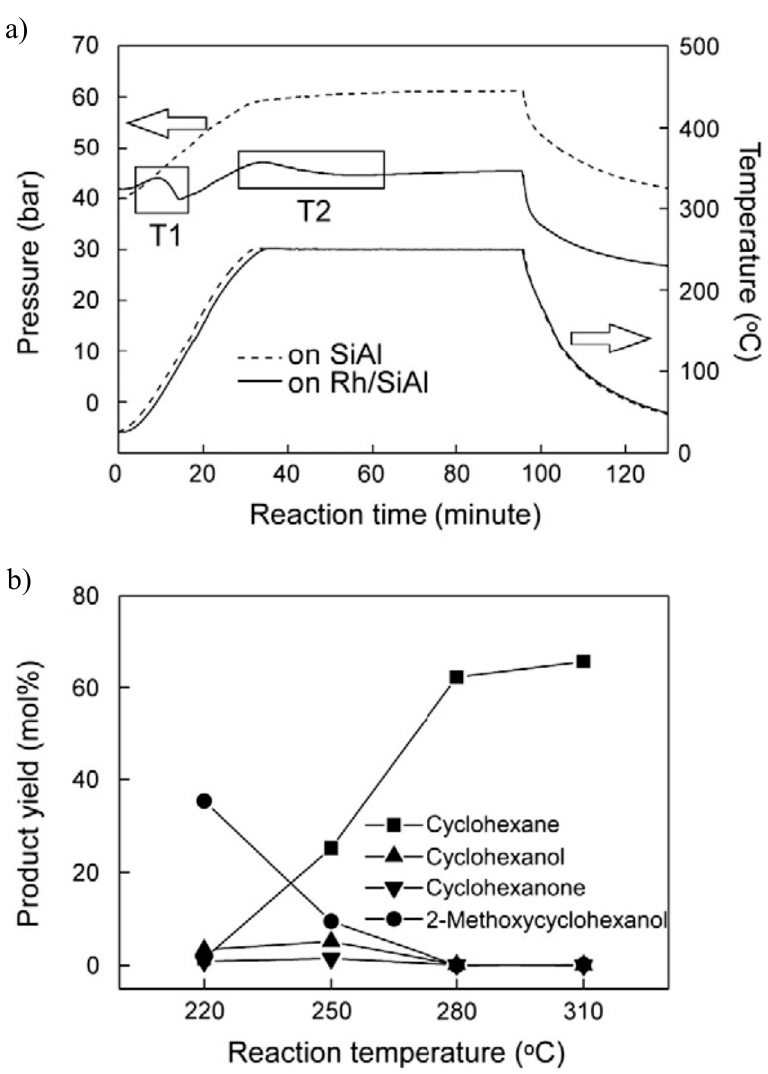
Figure 14. ( a ) Temperature and pressure profiles during HDO of guaiacol; ( b ) yields of different products in HDO of guaiacol as a function of temperature, solvent decane [45].